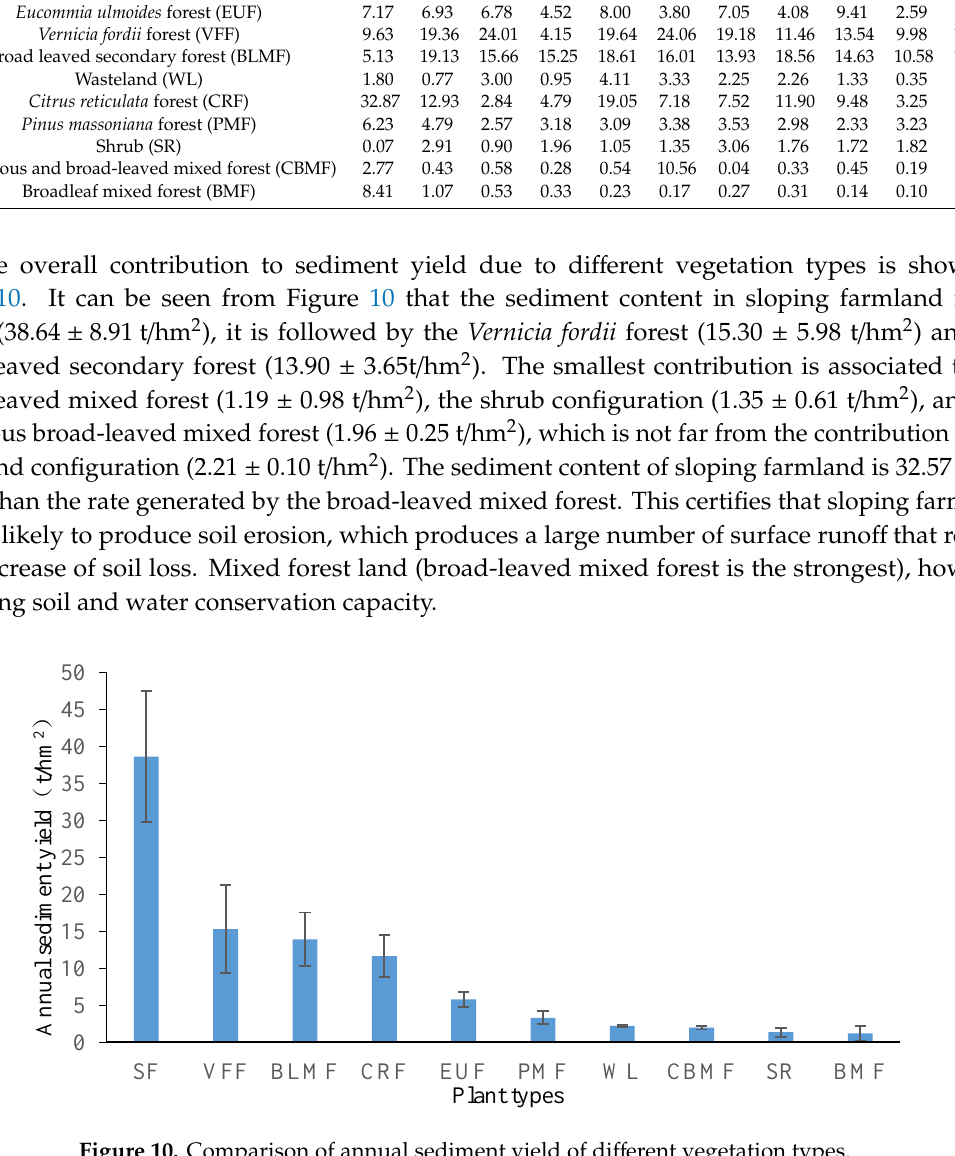
Figure 10. Comparison of annual sediment yield of different vegetation types.